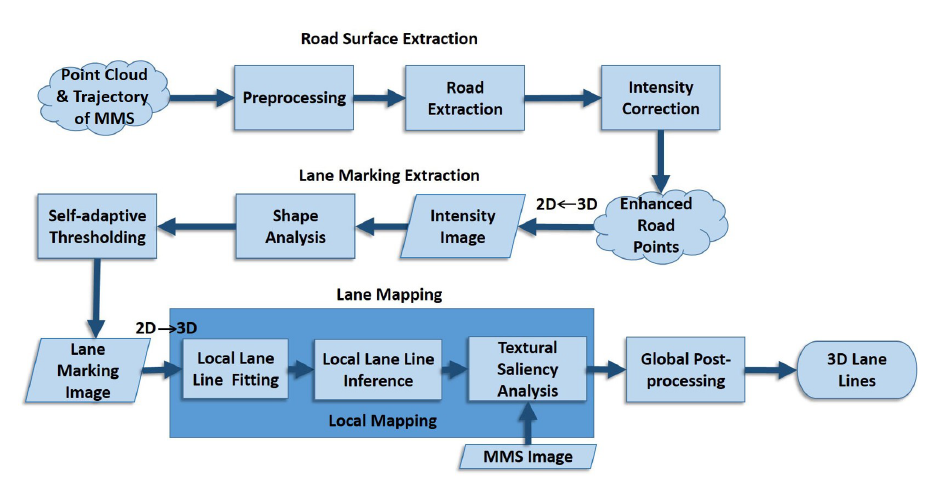
Figure 1. Overview of the